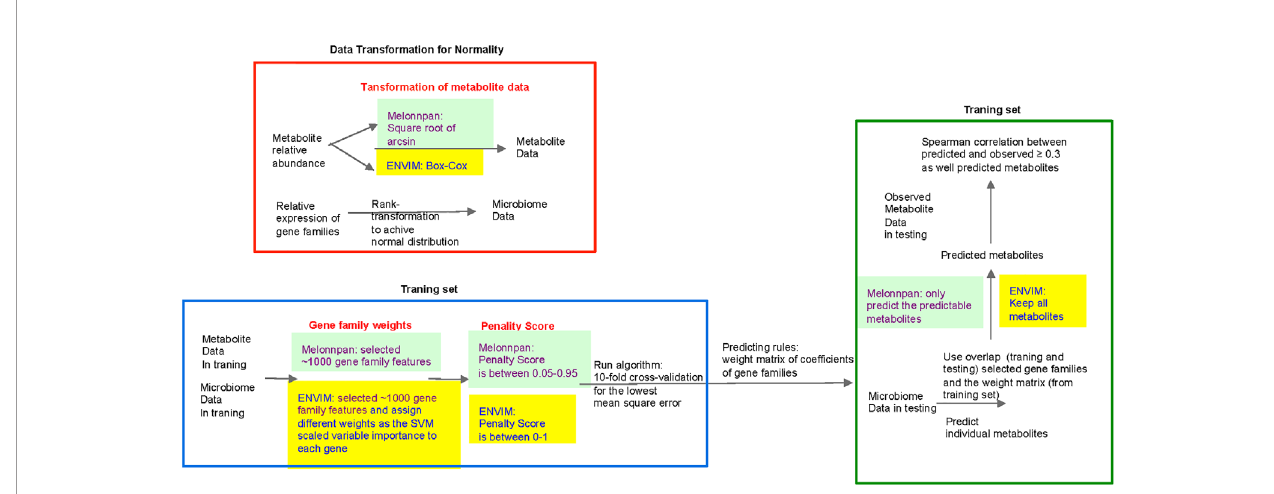
FIGURE 2 | Flowchart of MelonnPan and the elastic net variable importance model (ENVIM). The three differences between them include (red text) 1) transformation of metabolite data, 2) gene family weights, and 3) penalty score. The predictable metabolites are de fi ned as the metabolites that have a signi fi cant Spearman correlation with the adjusted q -value (testing whether the correlation is zero) below the default threshold in the training set.